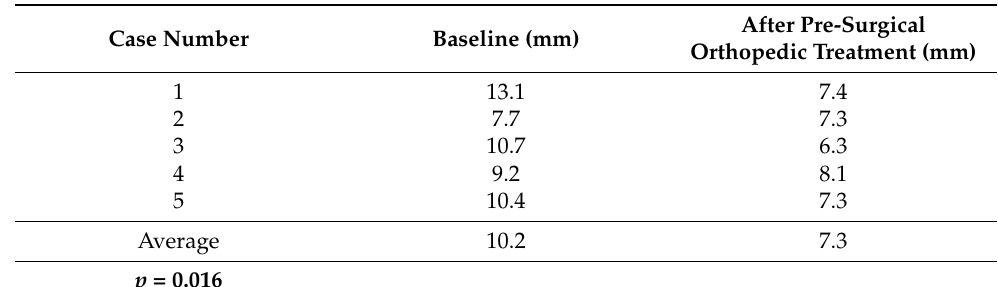
Table 1. Comparison of cleft lip width between baseline and after pre-surgical orthopedic treatment (upper point).